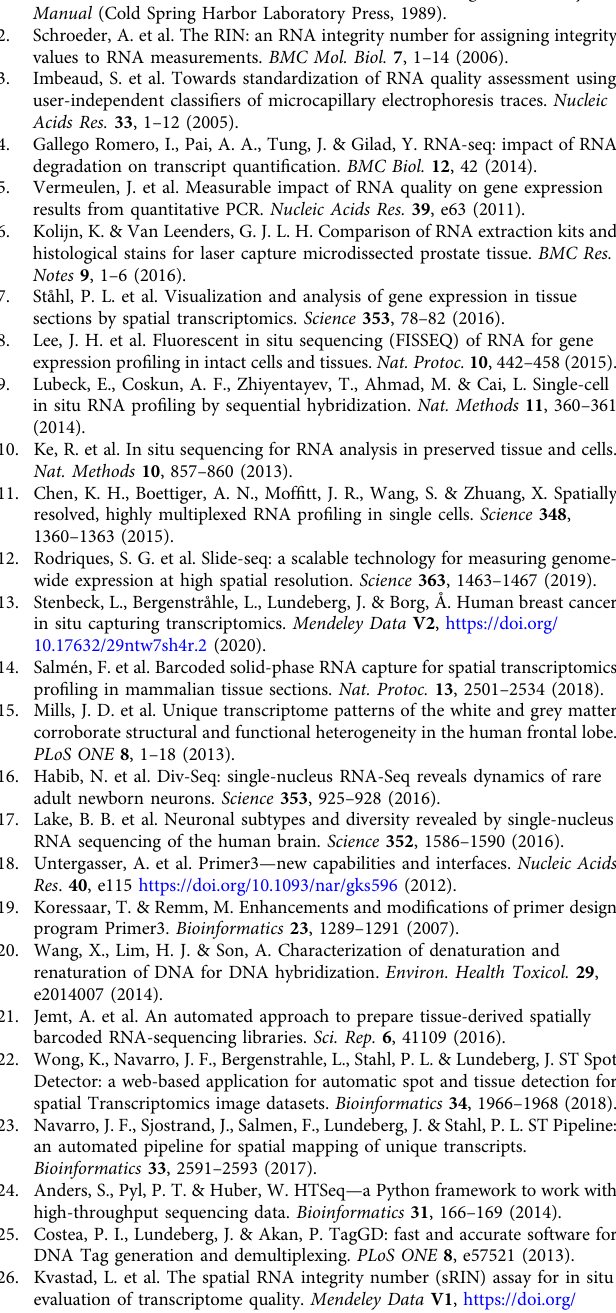
Supplementary Table 1. The original gel fi les, HE images, tif fi les used to generate the sRIN heat maps and graphs, count matrixes and spot coordinates used for ST plots and exon/intergenic mapping rate data are available in a dataset on Mendeley 26 . Raw fastq fi les for the breast cancer and childhood brain tumor samples are available through a Materials transfer agreement with Å.B. (ake.borg@med.lu.se) and M.N. (monica. nister@ki.se), respectively, in line with GDPR regulations. Further data supporting